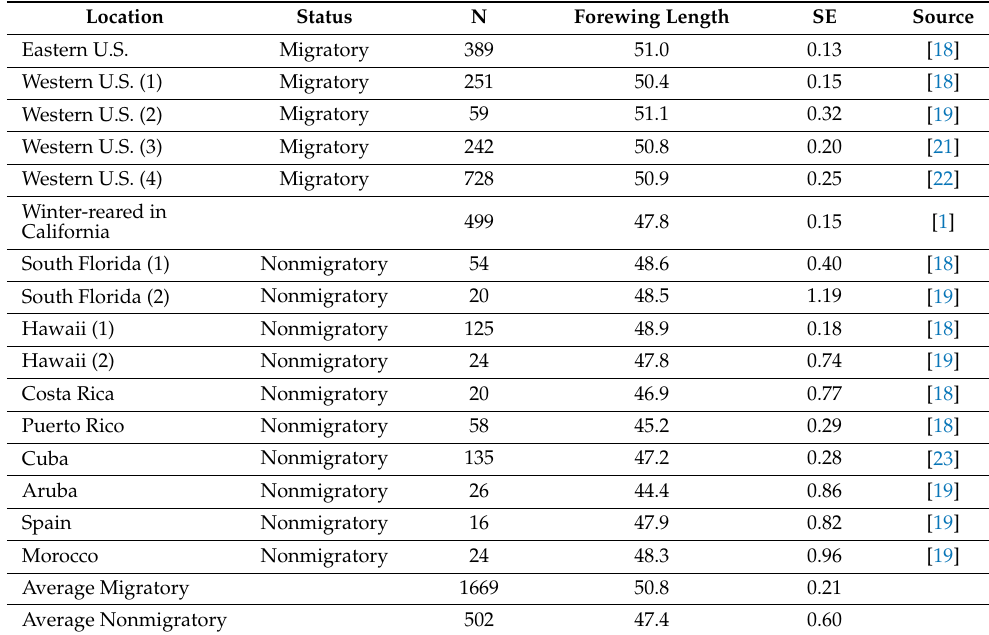
Table 1. Summary of published data on monarch wing lengths from around the world for comparison with James et al., 2021, who reared monarchs in winter in California. Mean forewing lengths (mm) are presented for each sample; males and females are